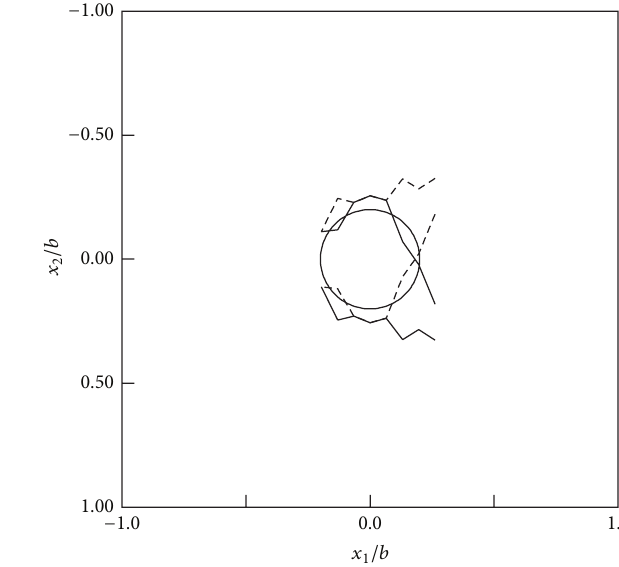
Figure 4: Reconstructed cavity with 𝑅 1 = 𝑅 2 = 0.2𝑏 , ̃𝑥 2 = −0.5𝑏 .